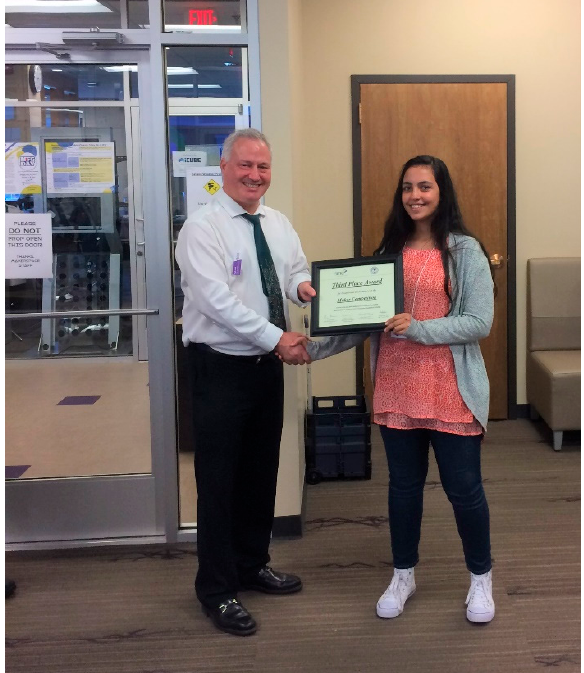
Figure 10. High School Award Program of the Manufacturing Day 2019 held at iMakerSpace Stu- dio.